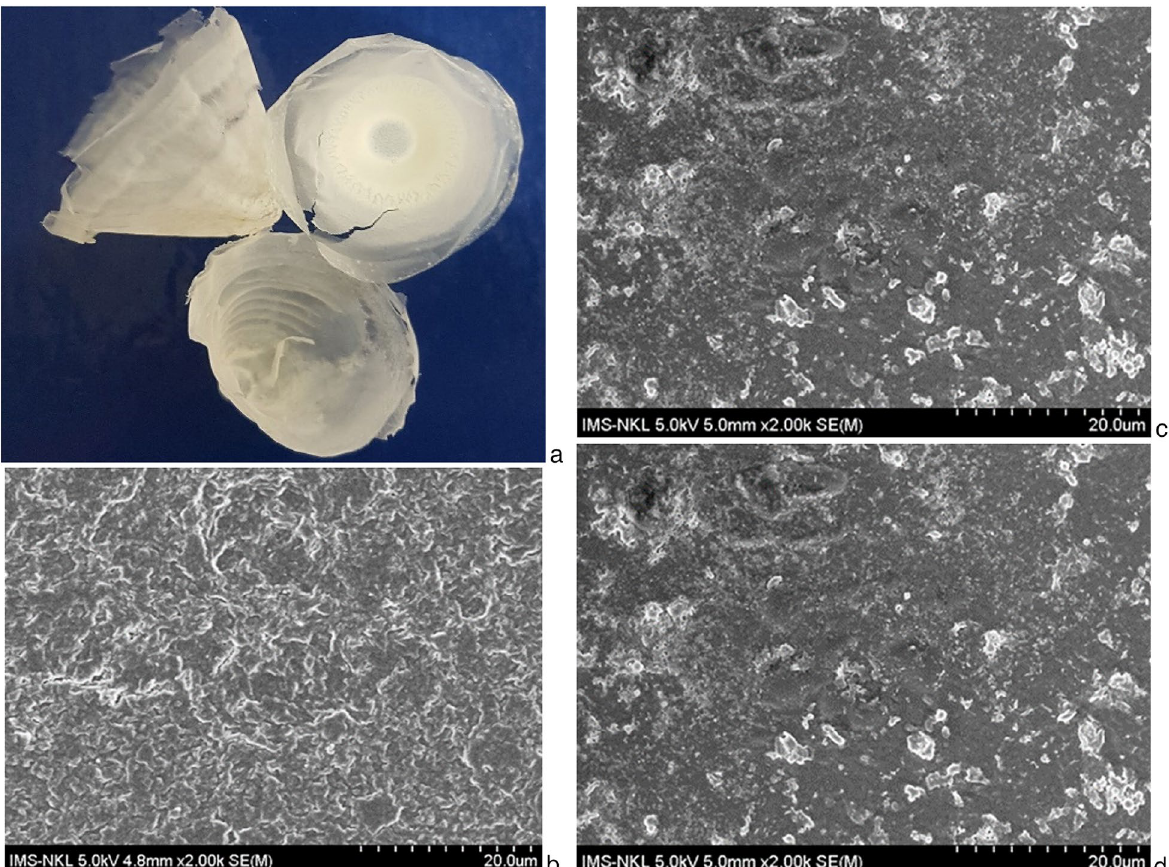
Figure 3. ( a ), PHA sample produced by Pichia sp. TSLS24; Changes in structure of PHA membranes after 28 days under TEM, magnification of 2000X: ( b ) Intact control PHA sample incubated in sterile sea water without microbes; ( c ) PHA sample degraded by natural microbes in non-sterile sea water; ( d ) PHA sample degraded by Pichia sp. TSLS24 in sterilized sea